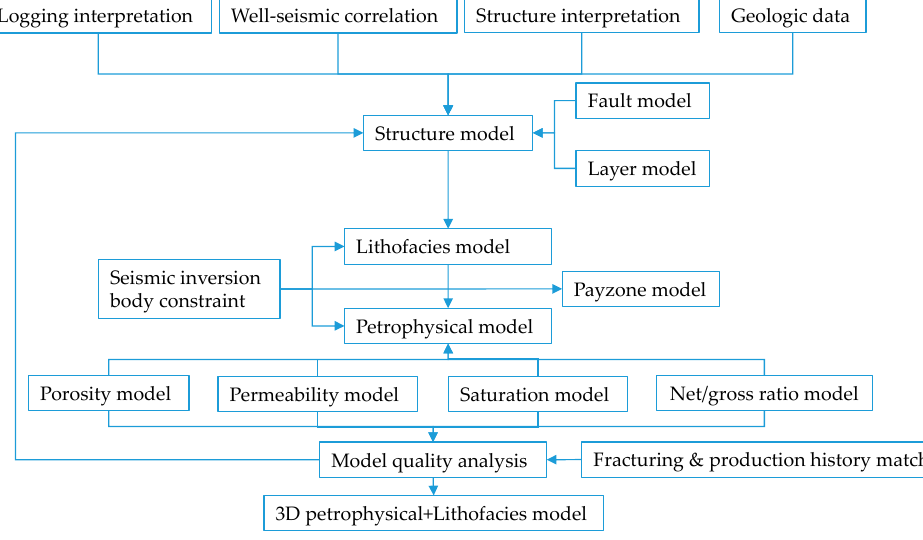
Figure 2. Workflow of the fine 3D petrophysical model.